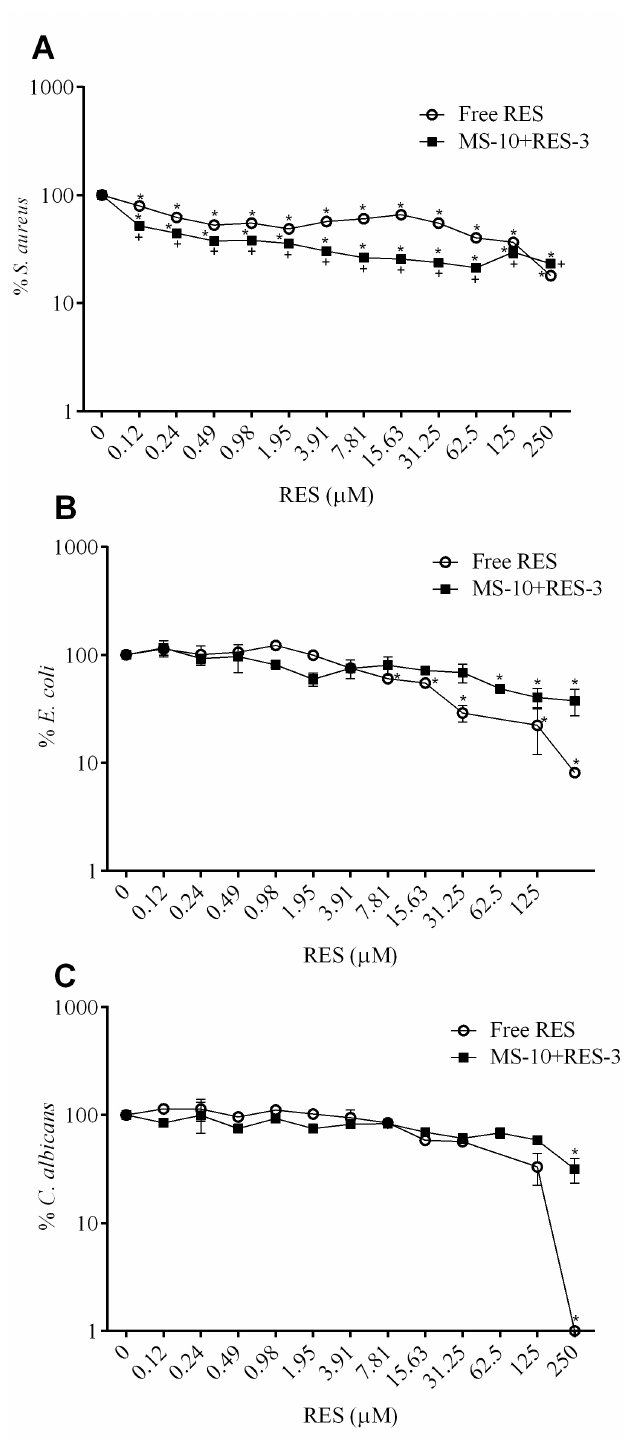
FIGURE 5 - Percentage of viable S. aureus (A), E. coli (B) and C. albicans (C) (logarithmic scale) after treatment with free resveratrol and formulation MS-10+RES-3 (10% F127 and 5000 µM). * p < 0.05 in relation to control without treatment with resveratrol. + p < 0.05 in relation to free resveratrol. Each point represents the mean values ± standard deviation obtained from three